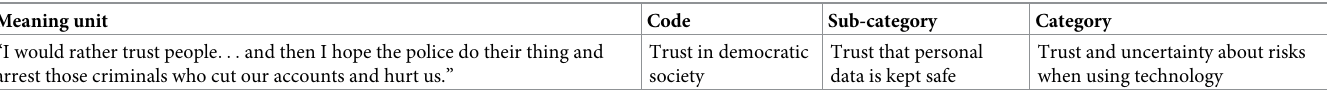
Table 1. Examples of meaning unit, code, sub-category, category. Meaning unit